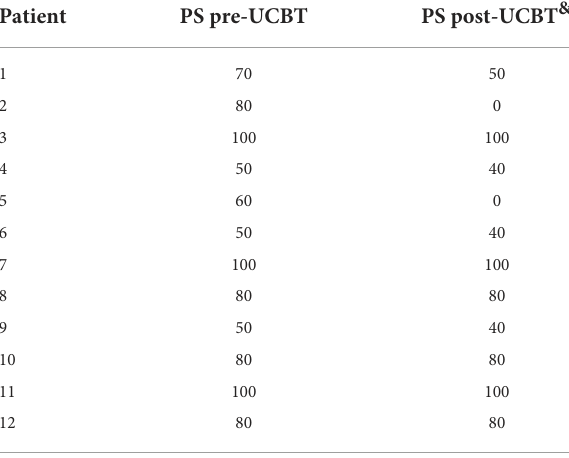
TABLE 4 Performance status scores of patients with heredity leukodystrophy pre-UCBT and